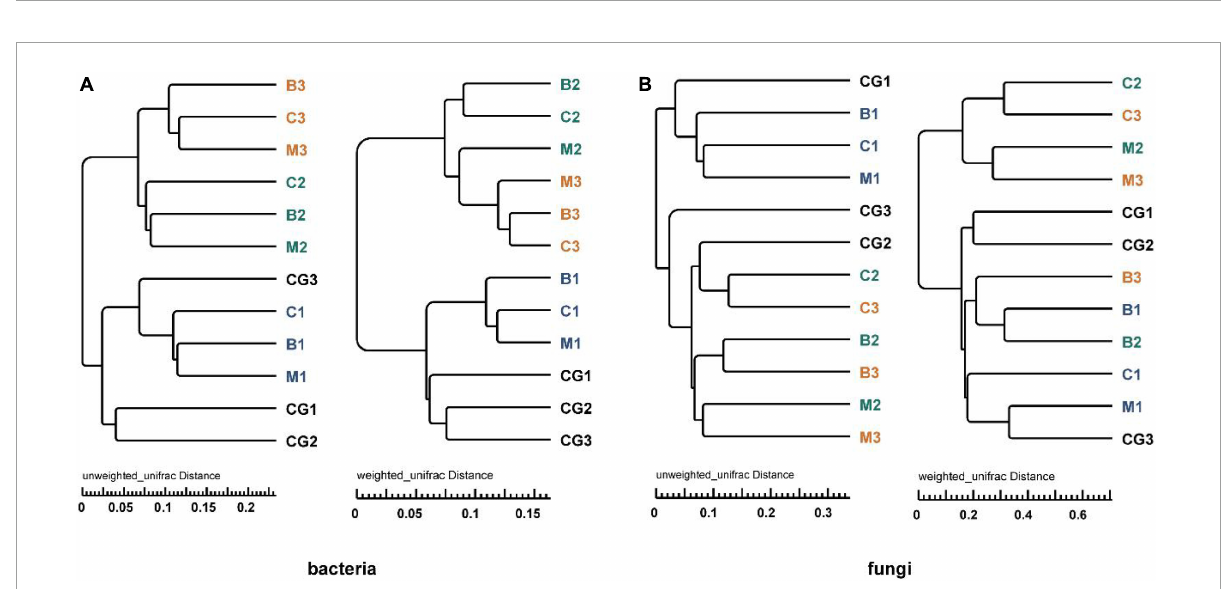
FIGURE6 UPGMA tree analysis of bacteria and fungi based on unweighted and weighted UniFrac distance. (A) Bacterial community, (B) fungal community. The letters in group ID represents nest material composition (B, bamboo leaf; C, couch grass; M, mixed litter; CG, control group); Arabic numerals represent different incubation periods (1, pre-incubation period; 2, mid-incubation period; 3, post-incubation